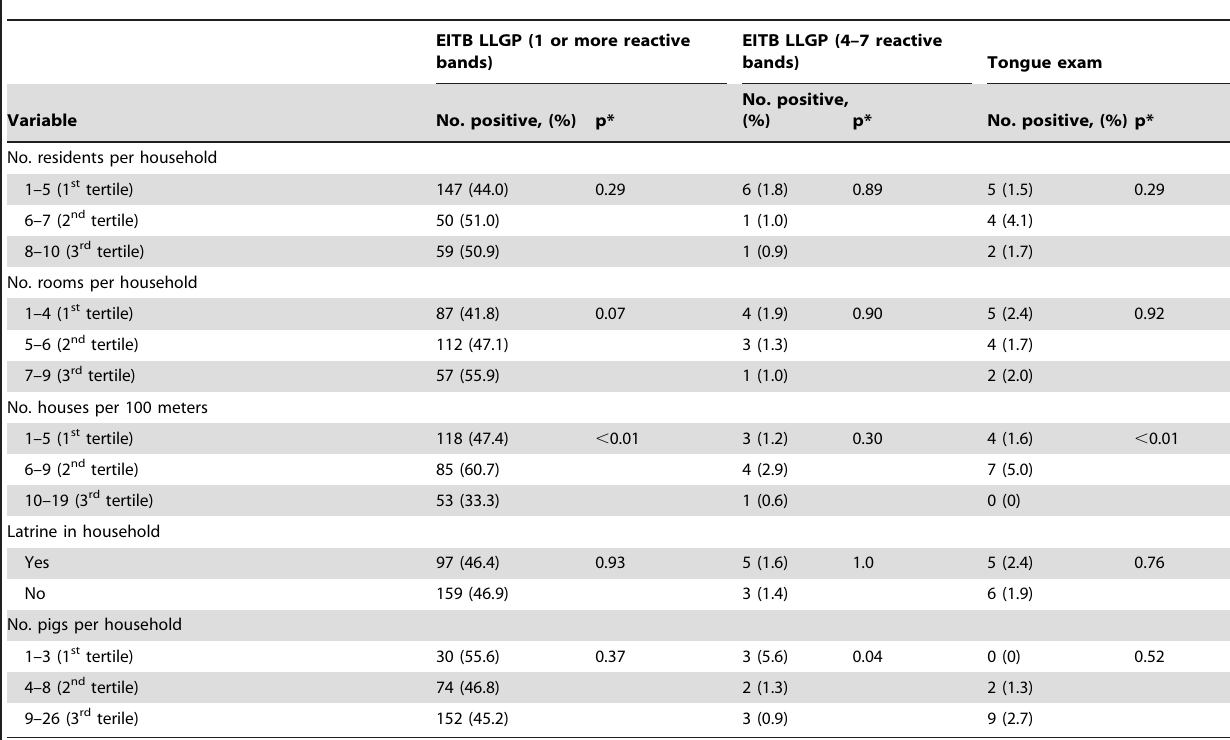
Table 2. Relationship between household characteristics and Taenia solium cysticercosis in pigs, Rica Playa, Tumbes,